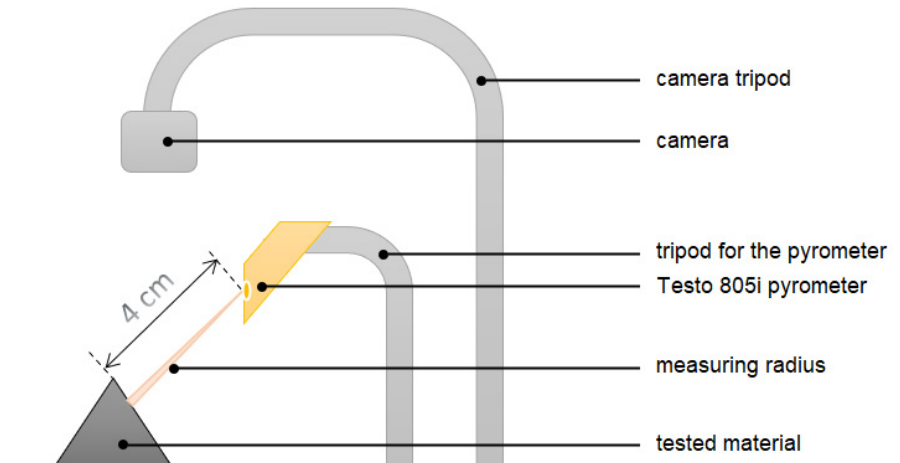
Figure 4. Non-contact measurement of temperature change during cutting-measuring system. A Testo 805i pyrometer (Pruszków, Poland) measured the temperature. Constant room temperature 21.6 °C, air-conditioned room. At a distance of 4 cm, the value of the temperature reading averaged over the area of 0.4 cm diameter area.